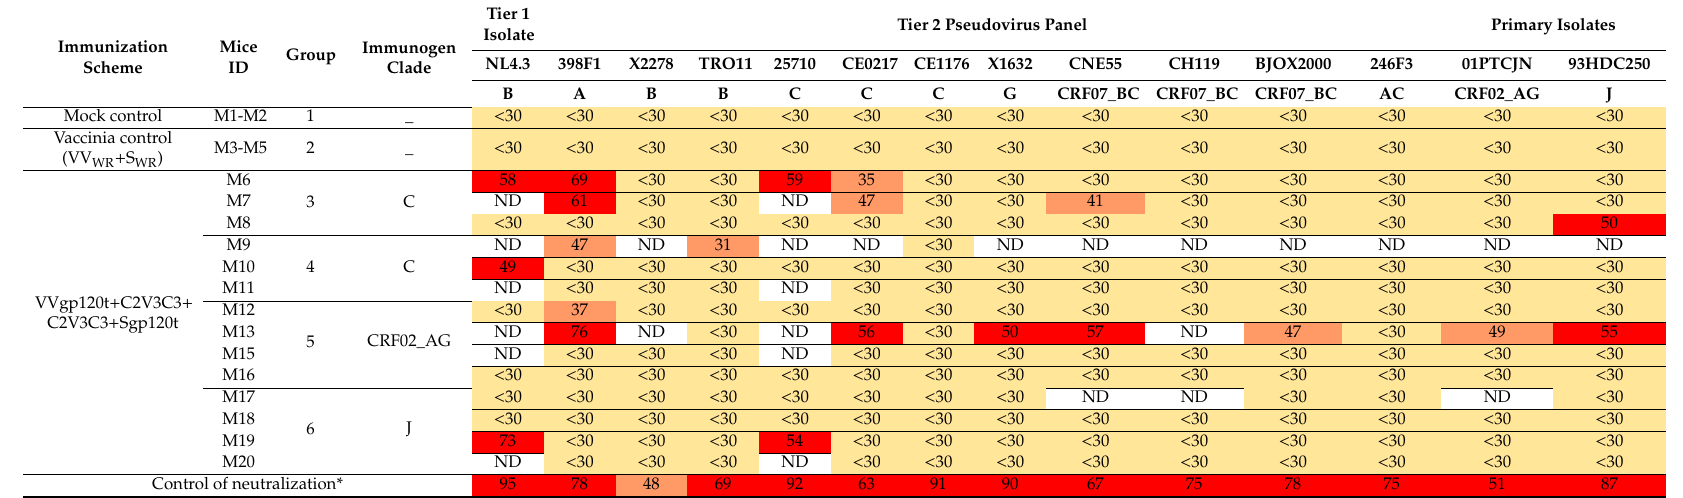
Table 4. Neutralizing activity in mice immunized in the pilot mice